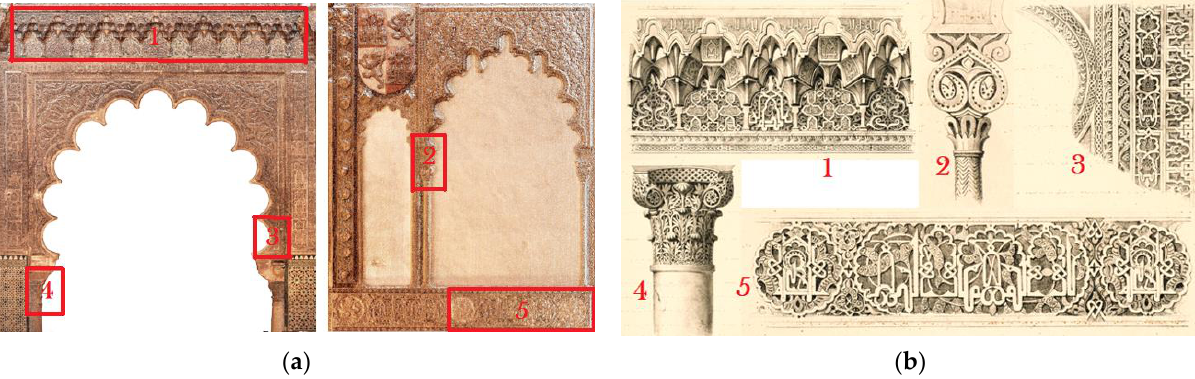
Figure 27. Details in the mihrab in the Royal Chapel: ( a ) Point cloud from laser scanner; ( b ) Lithographs published by Girault de Prangey (1839). Source: Own production.